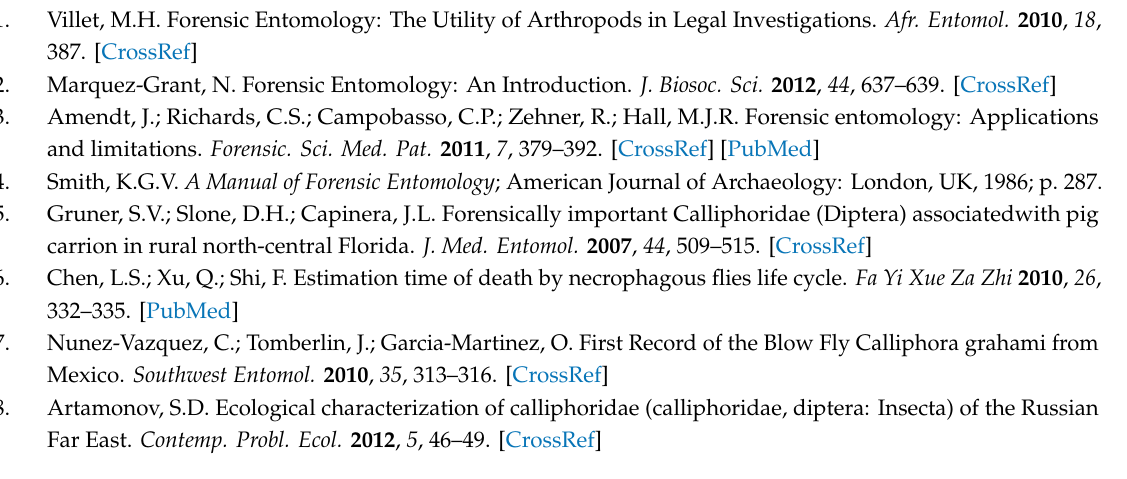
Figure S1: Change in larval body weight with time was shown in three groups constant versus fluctuating temperatures. The curve represents the fitting of larval body weight and time; Figure S2: In T8 ◦ C and F12 ◦ C adults were failing to make eclosion, and the pupa were vacuous. Table S1: Curve fitting equation, degrees of freedom (df), and coe ffi cients of determination (R 2 ) of the relationship between the body weight (W) (mg) of A. grahami larvae and the time after hatching (T) (h) at three fluctuating temperatures 6–12 ◦ C (F8 ◦ C), 10–16 ◦ C (F12 ◦ C), 14–20 ◦ C (F16 ◦ C), and constant temperatures 8 ◦ C (T8 ◦ C), 12 ◦ C (T12 ◦ C), 16 ◦ C (T16 ◦